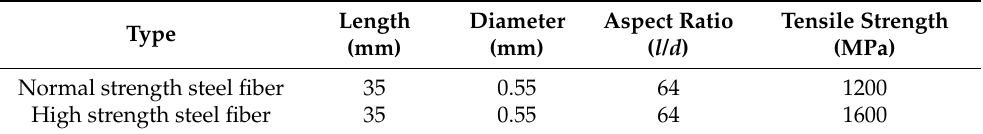
Table 3. Characteristics of Steel Fiber Used in Study.